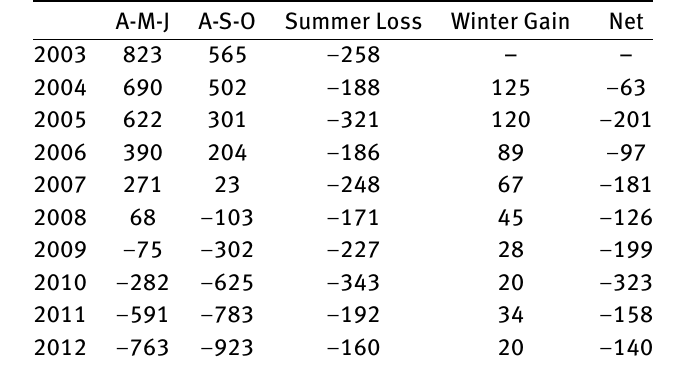
Table 1: The Greenland mass balance from GRACE monthly gravity field solutions provided by CSR. Smoothing radius of 180 km is used for these computations. The numbers in columns 2-6 are the average values of the total mass with respect to 2003-2012 mean. A-M-J is the April-May-June total mass and A-S-O is August-September-October total mass. Total masses are in